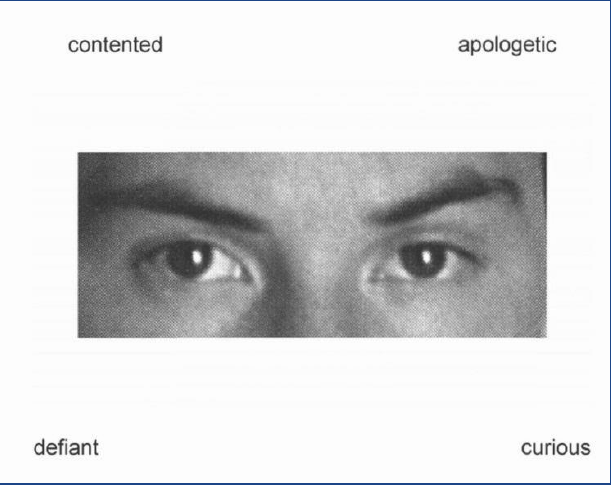
Figure 2. Example figure of Reading the Mind test item.